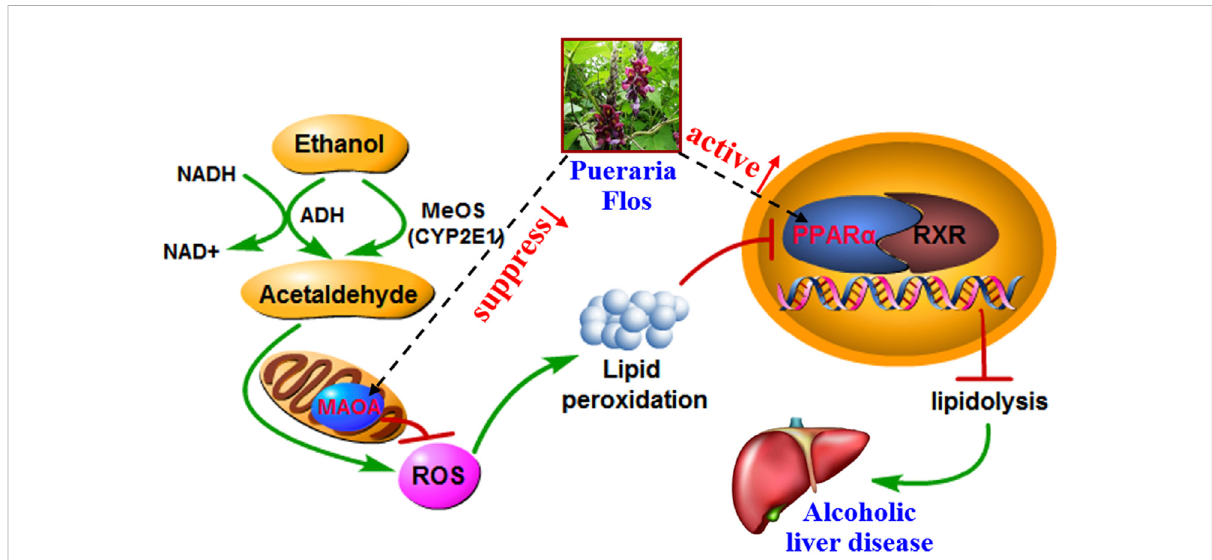
Overview of potential mechanisms underlying the protective effects of PF on alcohol-induced liver